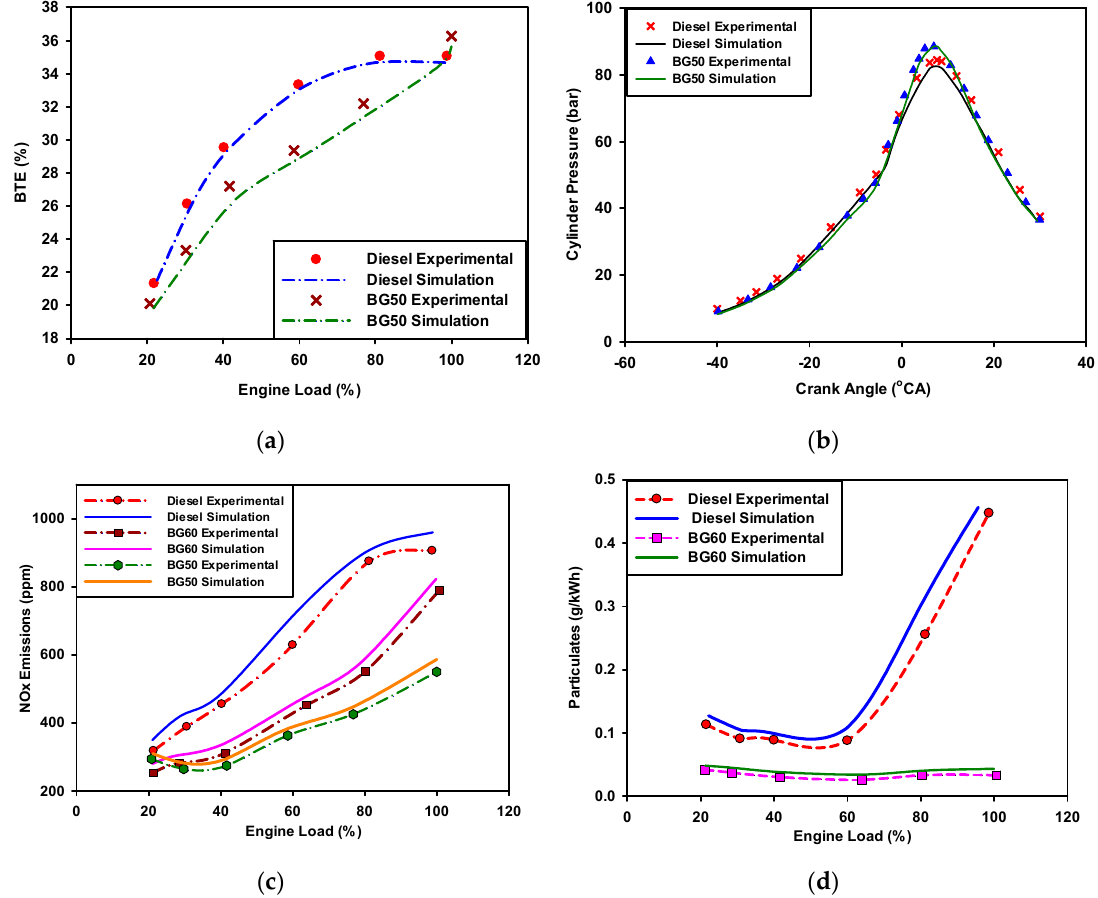
Figure 17. ( a ) Comparison of BTE between numerical and experimental for BG50 and diesel ( b )